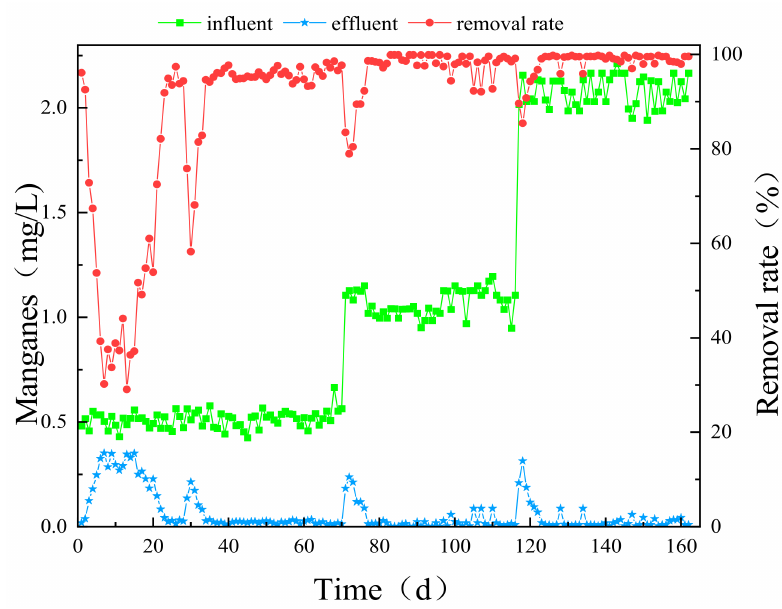
Figure 6. Manganese use reduction in aeration biofilter